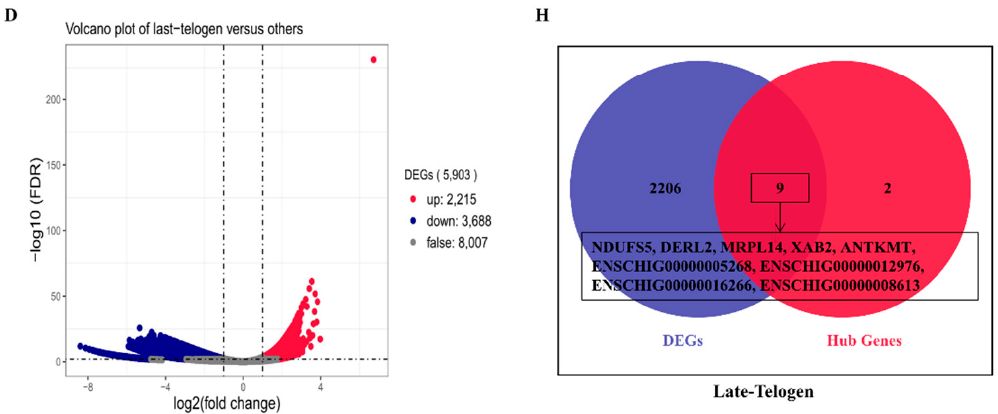
Figure 5. Differential expression hub genes related to different stages of hair follicle regeneration. The results of differential expression genes analysis in ( A ) anagen ( B) catagen, ( C ) telogen and ( D ) late-telogen compared with nonself stages. Overlapping results of up-regulated differential expression genes and hub genes in ( E ) anagen, ( F ) catagen, ( G ) telogen and ( H ) late-telogen.